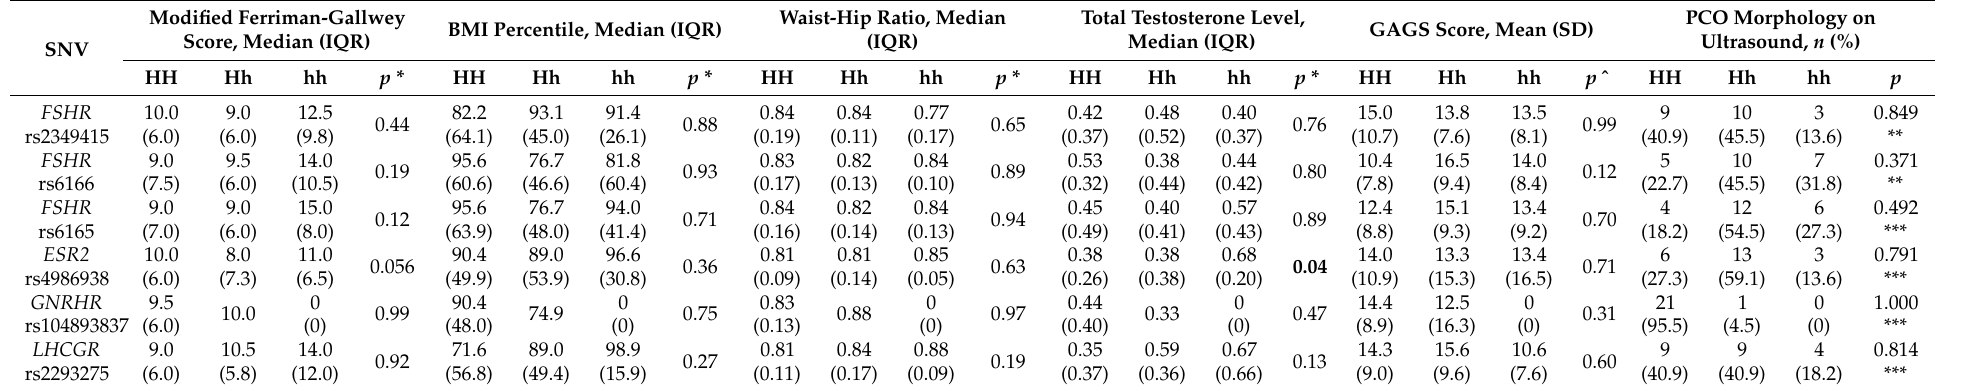
Table 3. Genotype-phenotype associations in PCOS patients.